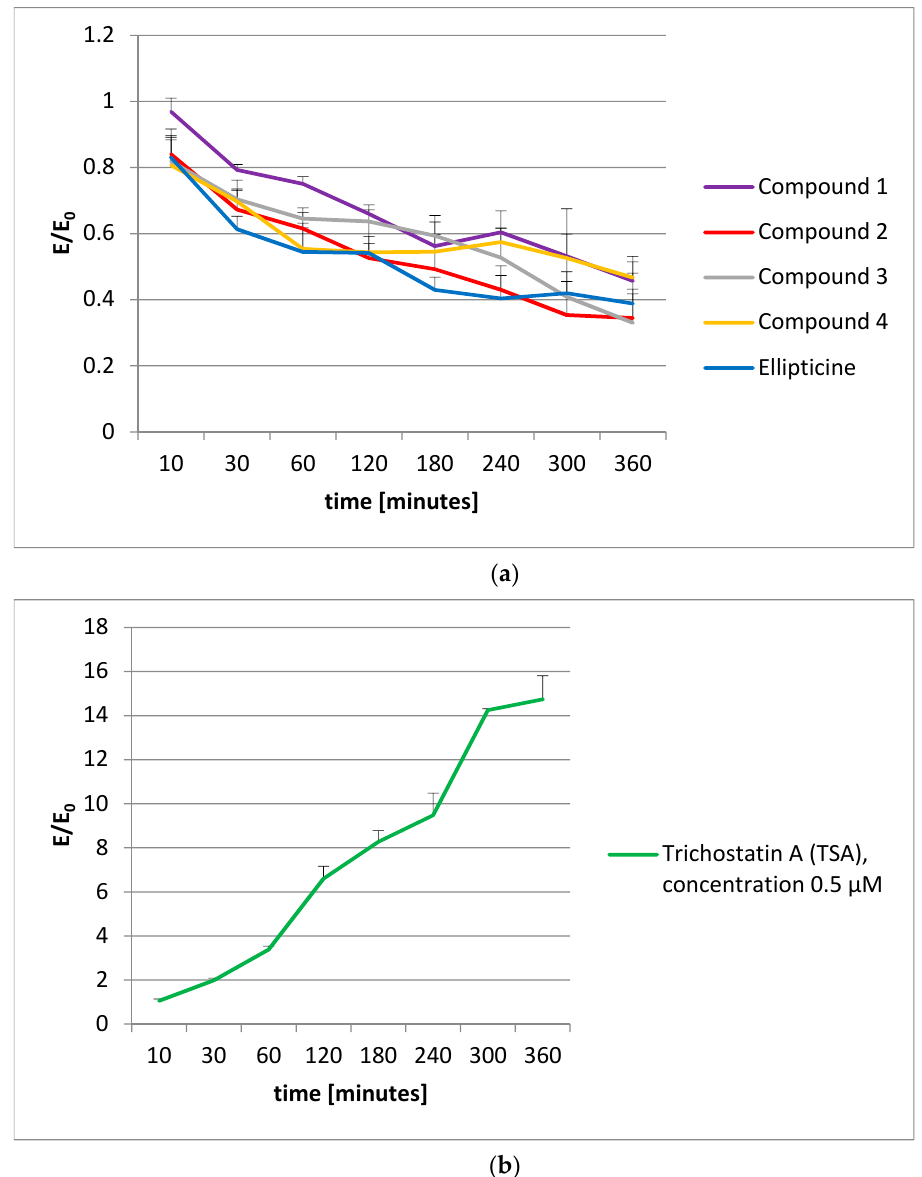
Figure 7. Histone acetylation, n = 5: ( a ) Studied compounds 1 – 4 and ellipticine in concentration of 10 µM; ( b ) trichostatin A (TSA) acetylation. E/E 0 is the mean value in reference to the control (E 0 = control = 1).